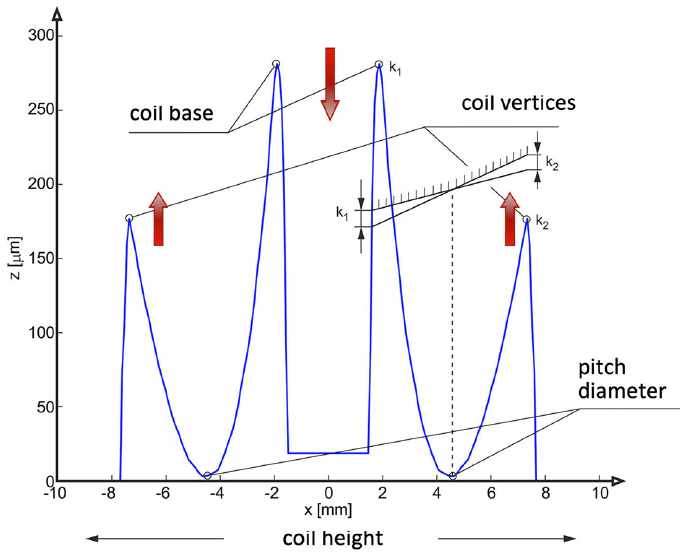
Figure 9. Projection on the x − z axial plane of the allowance values for grinding a helical surface with trapezoidal grinding wheel with rectilinear axial outline before the grinding